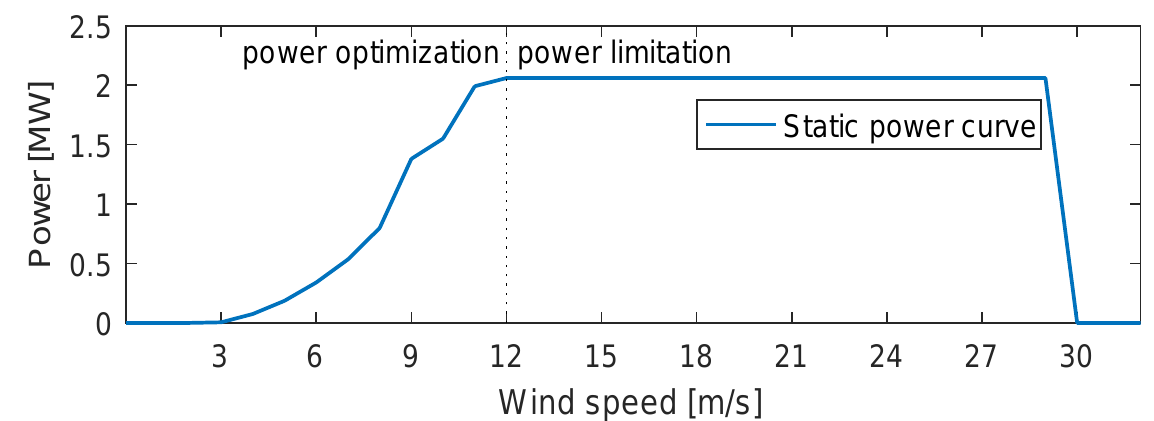
Figure 6. Doubly Fed Induction Generators (DFIG) wind turbine’s characteristic